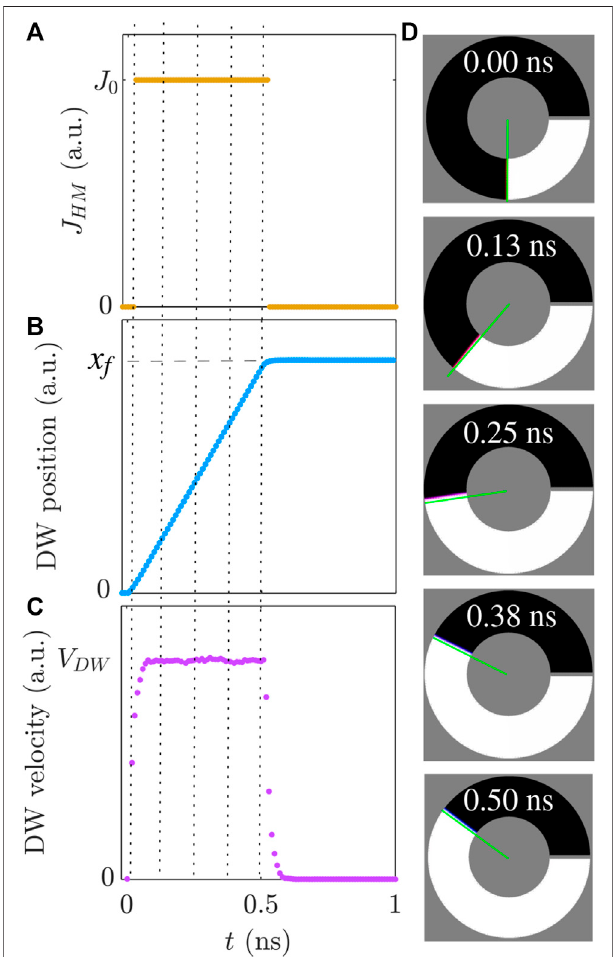
FIGURE 2 | Micromagnetic results of applying a uniform J HM (cid:2) J 0 (cid:2) 2 TA/m 2 (A) showing the relative and fi nal position x f (B) and velocity V DW (C) , as a function of time t , of an UD DW in a curved strip ( w (cid:2) 256 nm and r e (cid:2) 384 nm), at T (cid:2) 260 K. Insets (D) are snapshots of the magnetic con fi guration in sublattice i (cid:2) 1 at different times [highlighted by the vertical dotted lines in (A – C) ]. Green solid lines are for guiding the eye and are co- parallel with the strip radius.